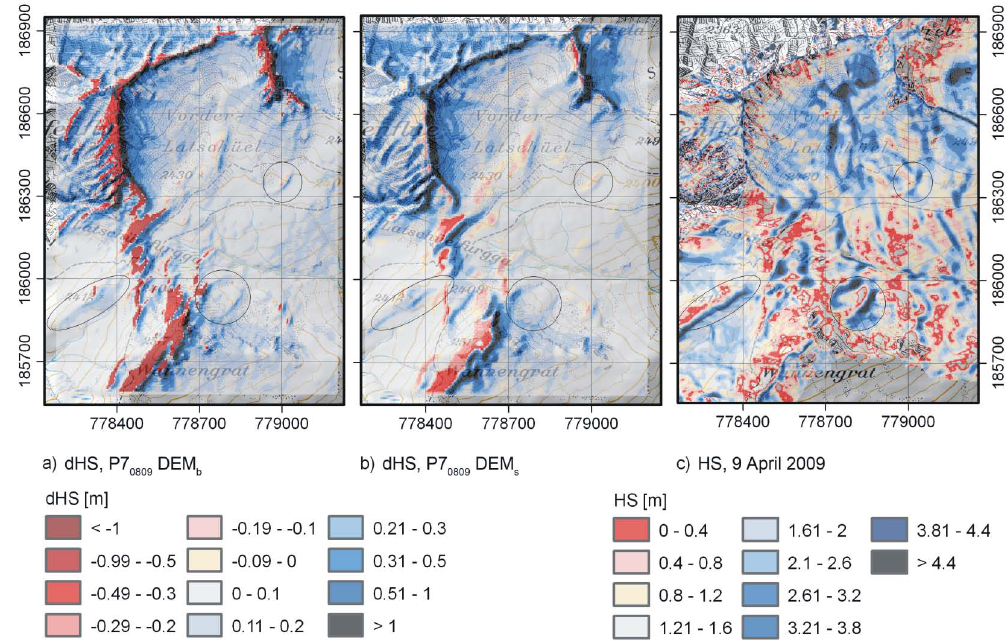
Fig. 9. Modeled changes in snow depth (dHS) for P7 0809 over bare ground (DEM b ) (a) and over snow-covered terrain (DEM s ) (b) for the whole model domain. Measured snow depths at time of peak accumulation 2008/09 (9 April 2009) with airborne laser scans with a horizontal resolution of 1m (c) . Circles indicate consistent deposition patterns. The x and y-axes give Swiss coordinates in meters. Horizontal grid resolution is 5 m. (basemap: Pixelkarte PK 25 ©2009 swisstopo (dv033492)).